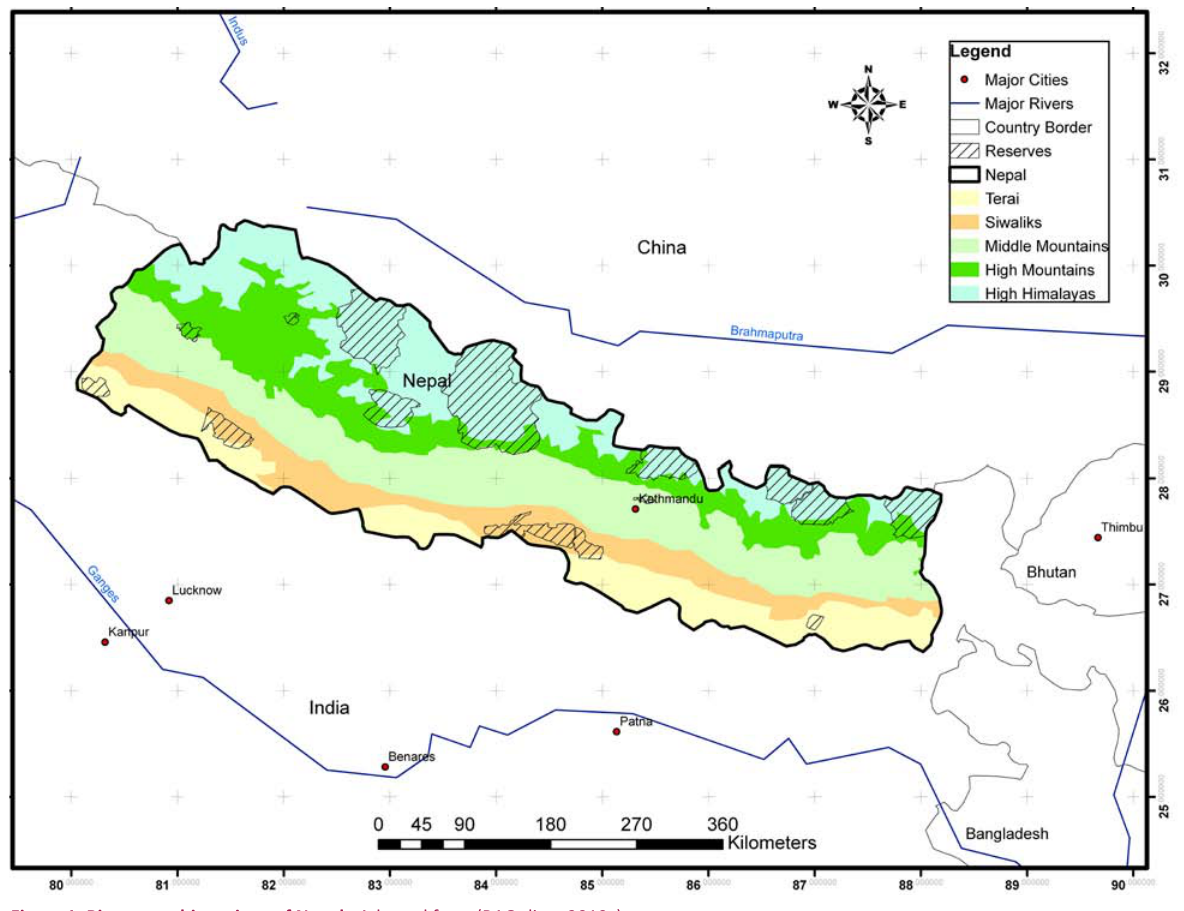
Figure 1. Biogeographic regions of Nepal. Adapted from (RAOnline, 2010c)